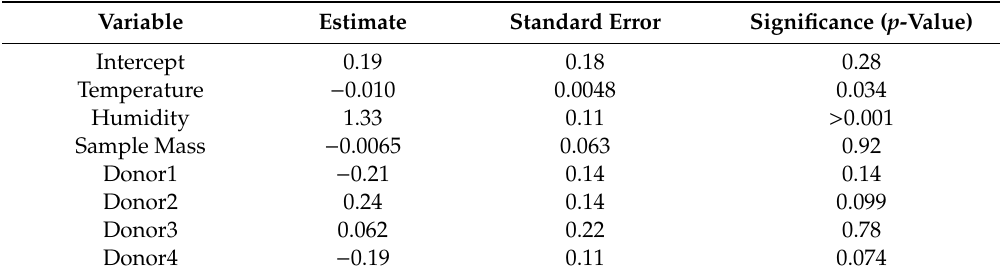
Table 3. Summary of regression coe ffi cients for multiple linear regression model (Equation (2)) (ANOVA, F(4, 394) = 39.38, p -value < 0.01) relating to equilibrium moisture content with the factors of temperature, humidity, sample mass, and